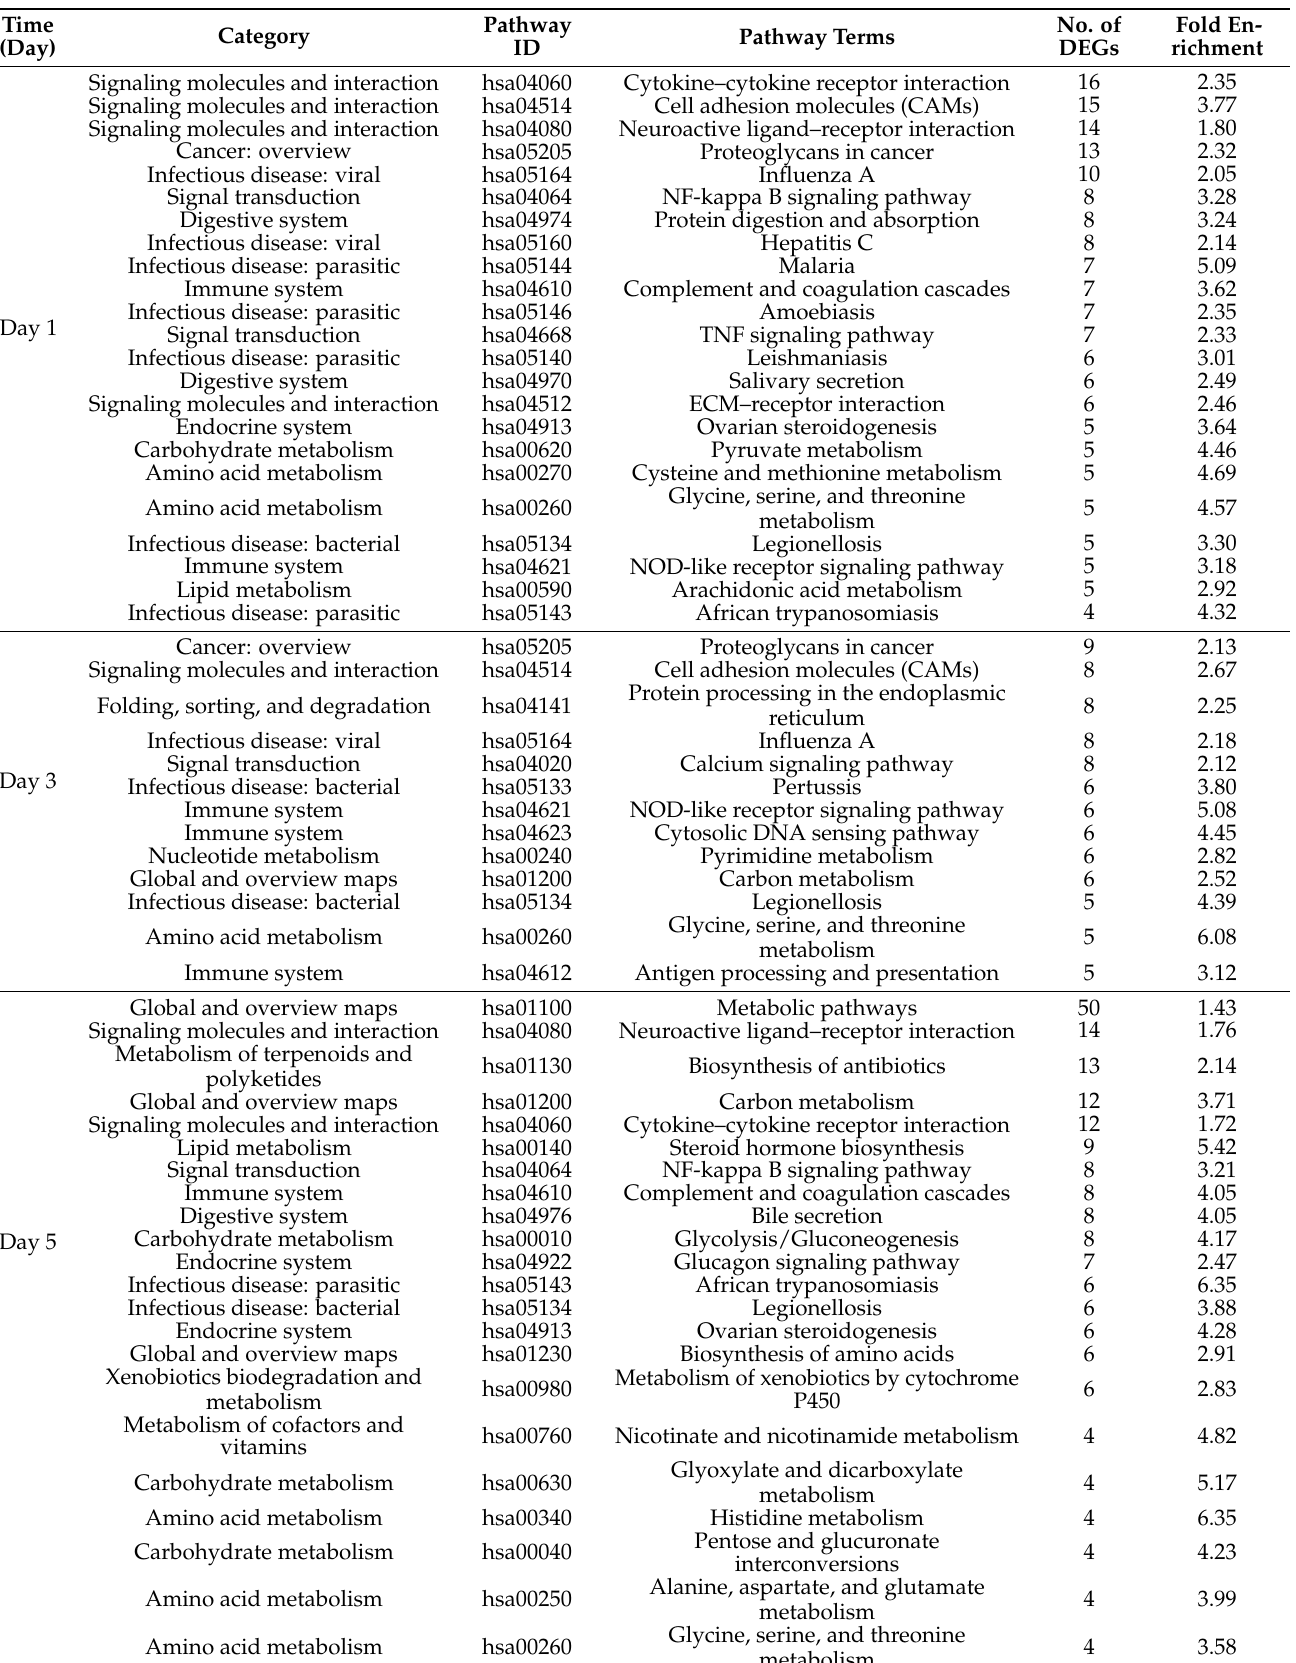
Table 1. KEGG classification of differentially expressed genes (DEGs) between PBS and AV groups at days 1, 3, and 5. Time